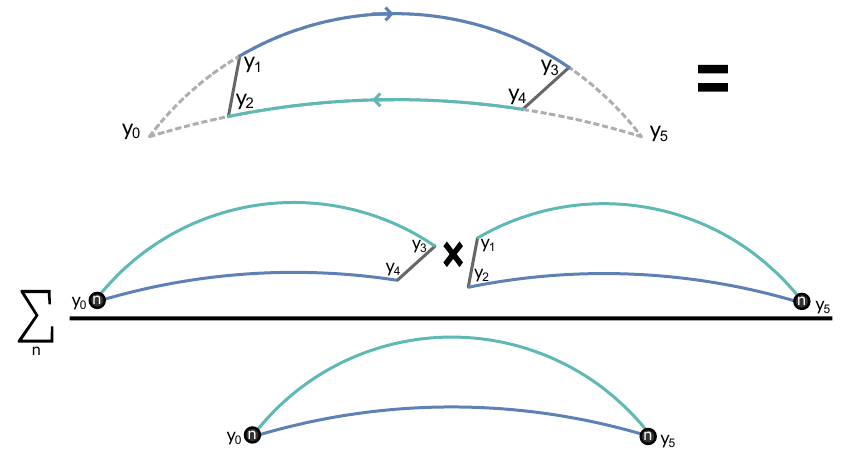
Figure 20 . The OPE decomposition of the four-point function, illustrating equation